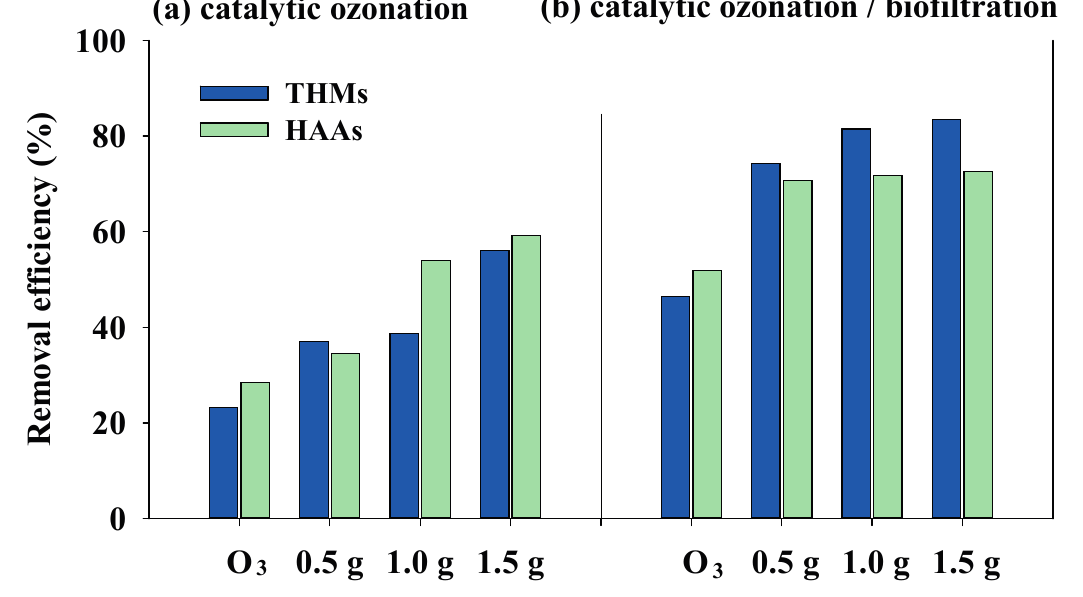
Figure 6. Removal efficiencies of THMs and HAAs with various catalyst dosages for ( a ) catalytic ozonation alone and ( b ) catalytic ozonation followed by biofiltration (ozone concentration: 2.5 mg·L − 1 ; gas flow: 50 mL·min − 1